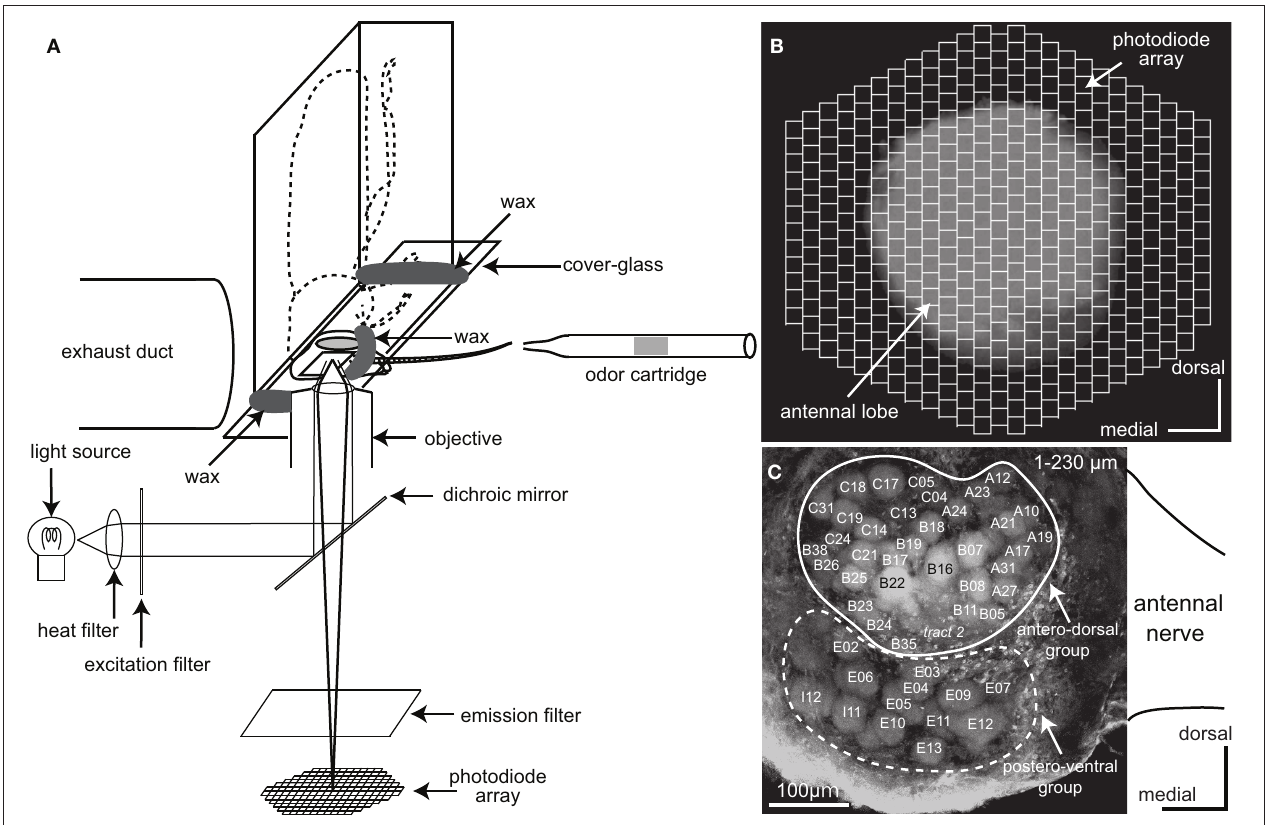
Each photodiode corresponds to a 25 × 25 µ m area of the cockroach AL and the 454-element photodiode array covered the whole anterior surface of the cockroach AL. (C) Reconstructed confocal image of the cockroach AL (230 µ m image stack). In this study VSD imaging simultaneously recorded changes of the membrane potentials in both the antero-dorsal and the postero-ventral groups of glomeruli located just beneath the anterior surface of the AL. The nomenclatures of the glomeruli and the sensory tracts are from Watanabe et al. (2010). Glomeruli surrounded by solid and broken lines belong to the antero-dorsal and the postero-ventral groups,